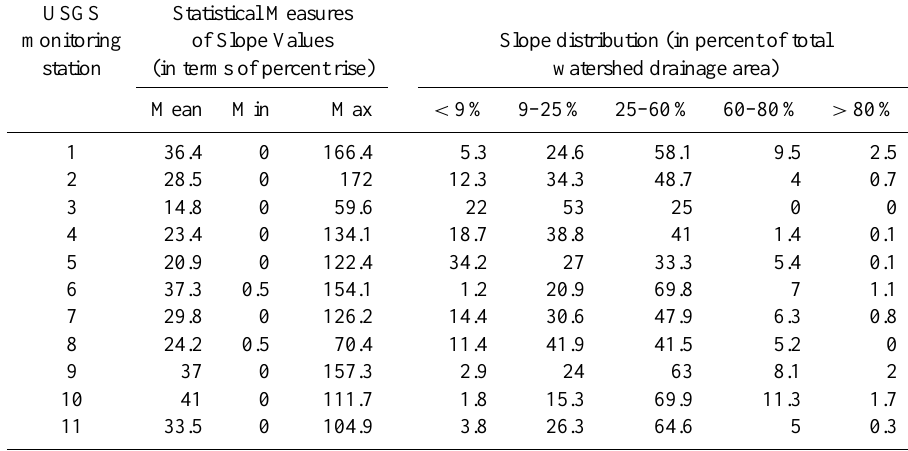
Table 5. Statistical measures of slope and its distribution (in percent of total watershed drainage area).